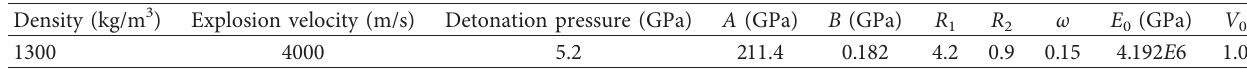
Table 4: Material and state equation parameters of the explosive [28].